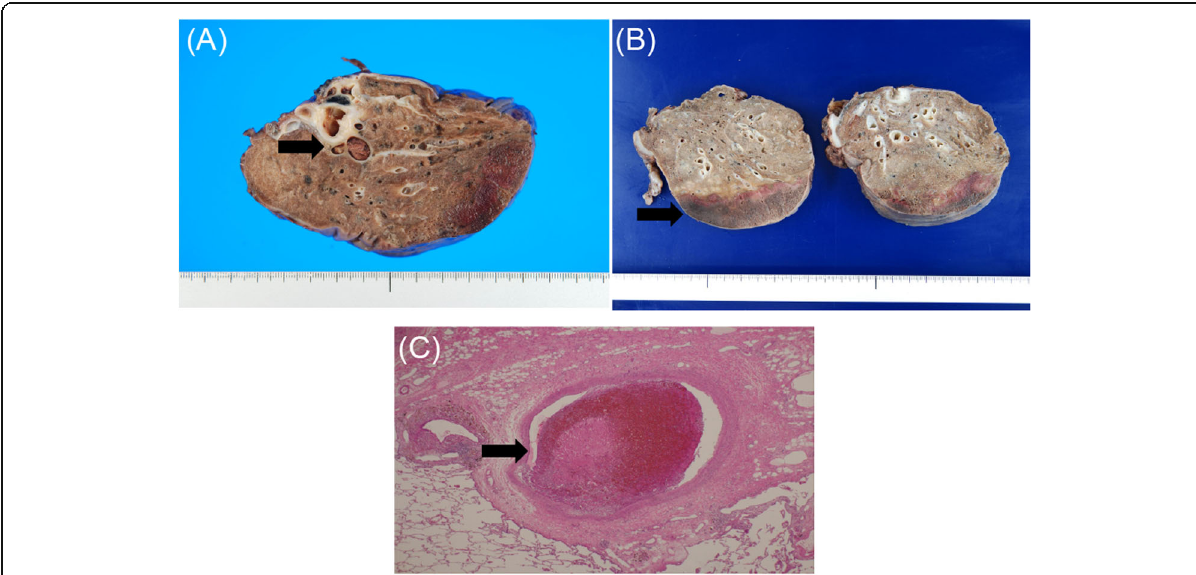
Fig. 2 Histopathological findings. a Macroscopic findings: a light brown thrombus is visible in the pulmonary artery and dark red necrosis is visible in the peripheral pulmonary parenchyma. b Macroscopic findings: three layers of tissues (normal lung, intra-alveolar hemorrhage, and pulmonary necrosis layers) are visible from the proximal to the distal direction. c Microscopic findings: an organized thrombus is present in the pulmonary artery. Endothelial coverage, hyalinized fibrin, development of capillaries, and infiltration of fibroblasts are observed in the periphery of the thrombus, indicating its